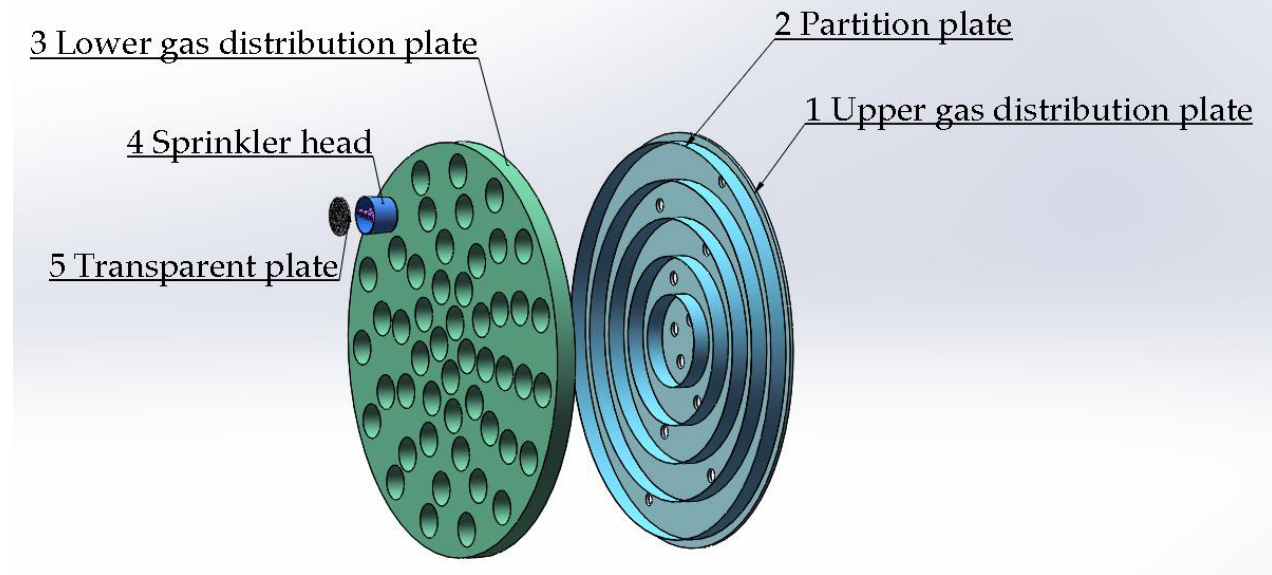
Figure 6. Schematic diagram of the assembly of the secondary gas distribution device.